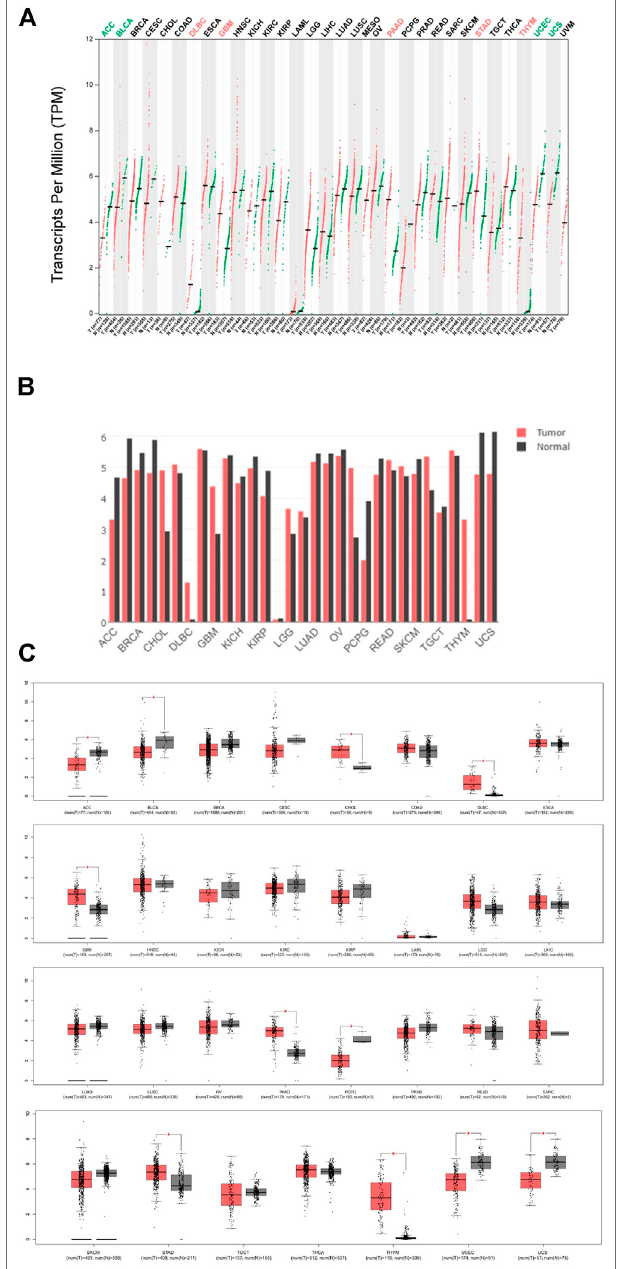
FIGURE 3 | Expression of YAP1 in different cancers (GEPIA). (A) YAP1 expression pro fi le across all tumor samples and paired normal tissues (dot plot). (B) YAP1 expression pro fi le across all tumor samples and paired normal tissues (Bar plot). (C) YAP1 expression pro fi le across all tumor samples and paired normal tissues (box